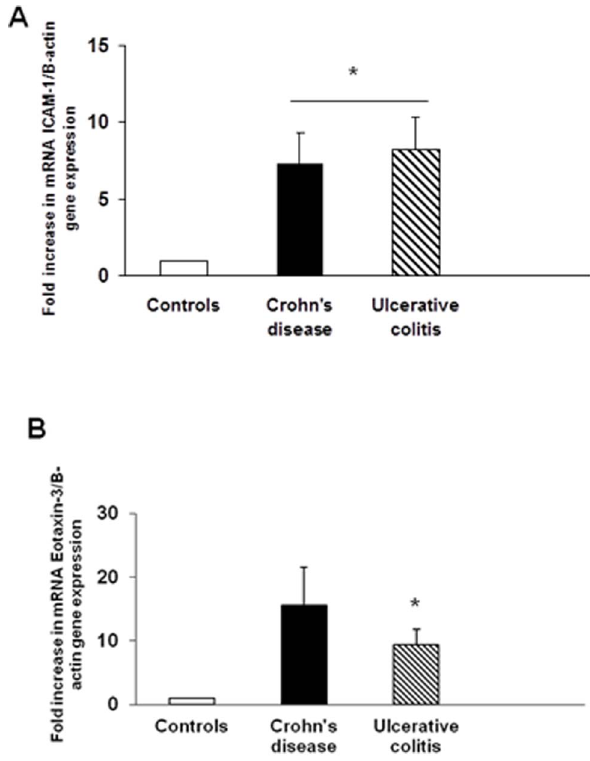
Figure 5. Up-regulation of eotaxin-3 and ICAM-1 expression in patients with refractory IBD. In graphs A and B, ICAM-1 and eotaxin- 3 expression are shown as the fold increase of gene product normalized for b -actin from the same cDNA sample above control (normal bowel tissue). Controls n=5; UC n=4; CD n=3, *p , 0.05.